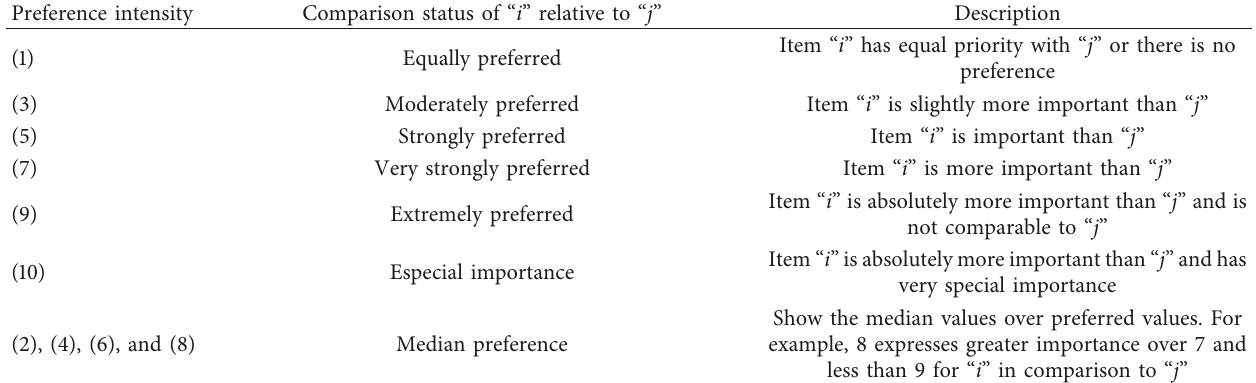
Table 8: Preference intensity evaluation by binary comparison relatively between criterions in AHP [16].